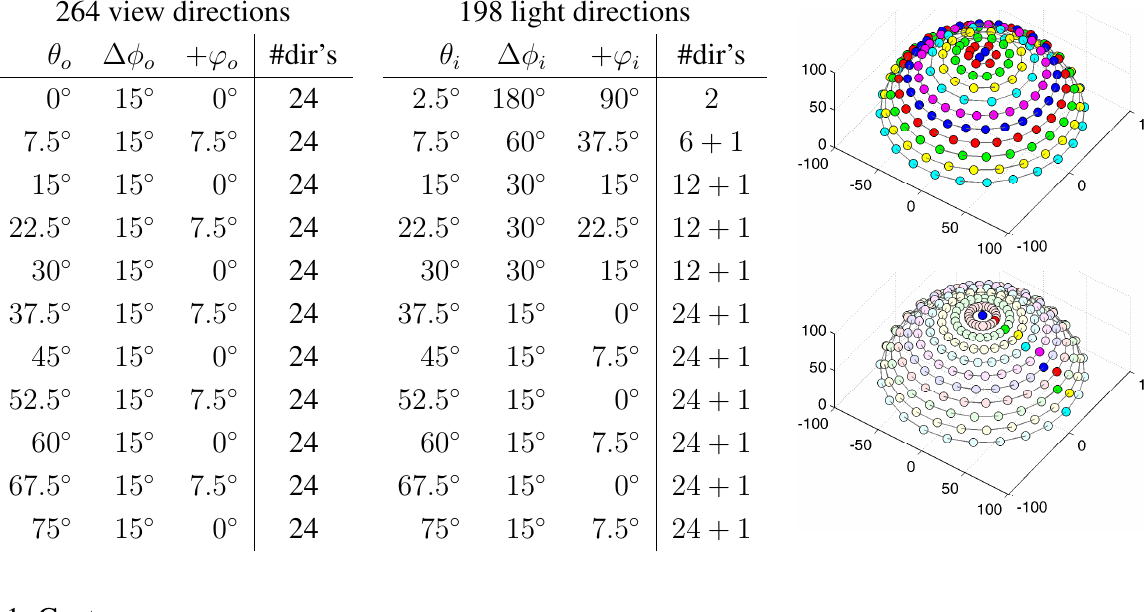
Table 5. The hemispherical direction-samplings in our Dome 2 setup. On every second ring, the azimuthal view angle φ o is displaced by ϕ o = 7 . 5 ◦ . On each ring, the azimuthal light angle φ i is displaced by ϕ i to be arranged symmetrically around the cameras. Furthermore, there is one additional lamp in every ring except the first at φ i = φ o + 180 ◦ , i.e. , the perfect mirror direction of the respective